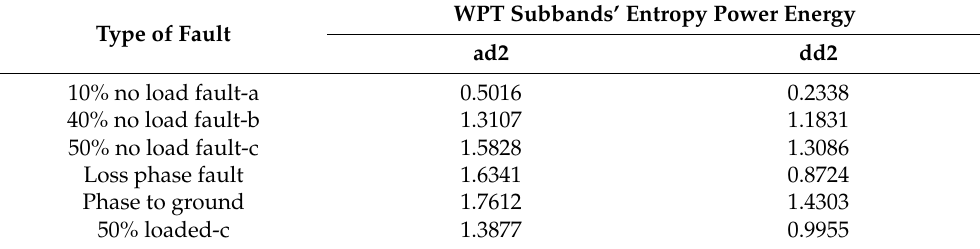
Table 6. Computed Entropy power energy threshold values for the classification of the faults using experimental data.